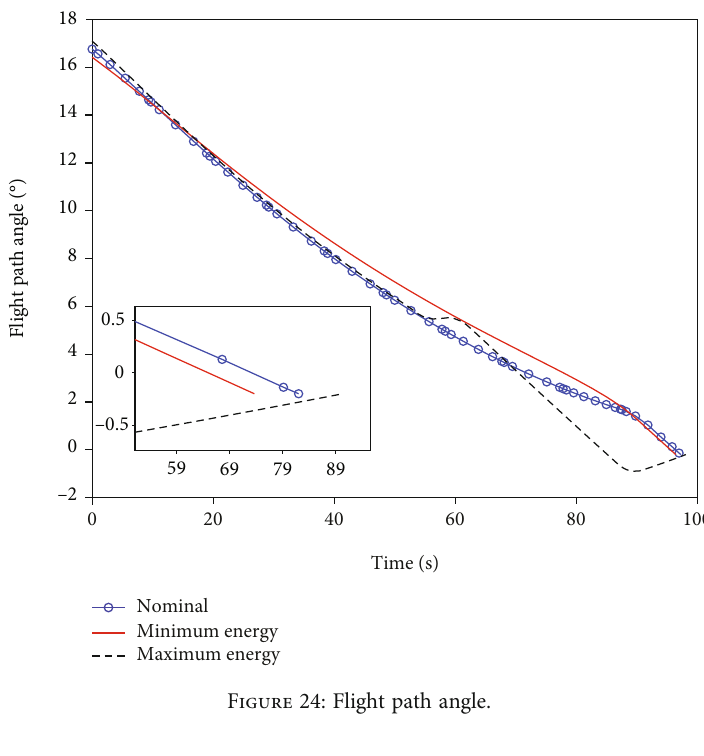
Figure 24: Flight path angle.